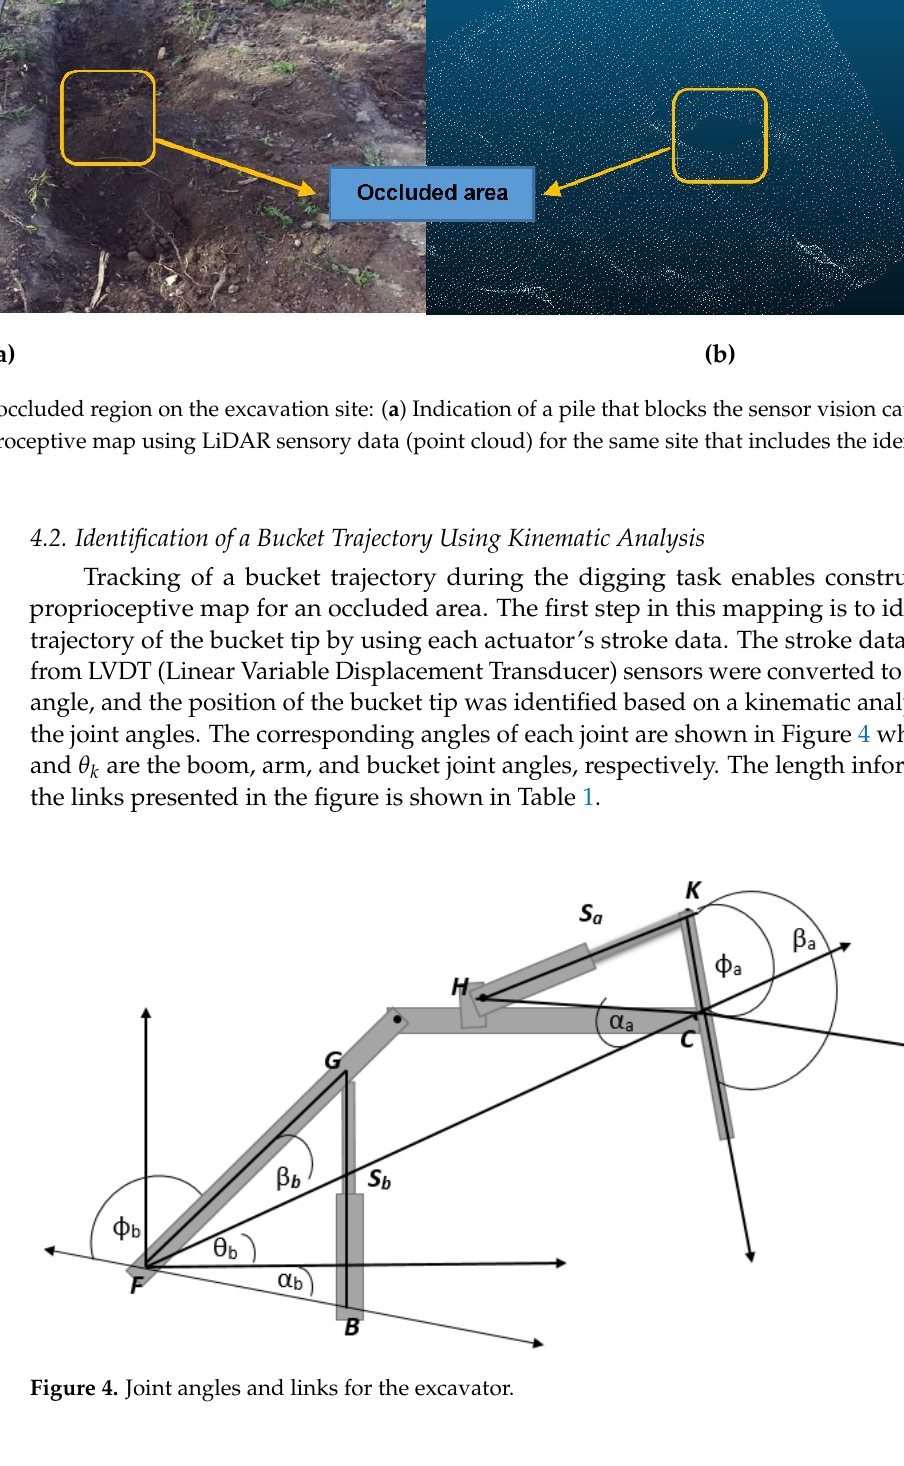
Figure 2. An example of an occlusion area: A pile on the ground blocks the sensor vision that hin- ders detection of the occluded area.